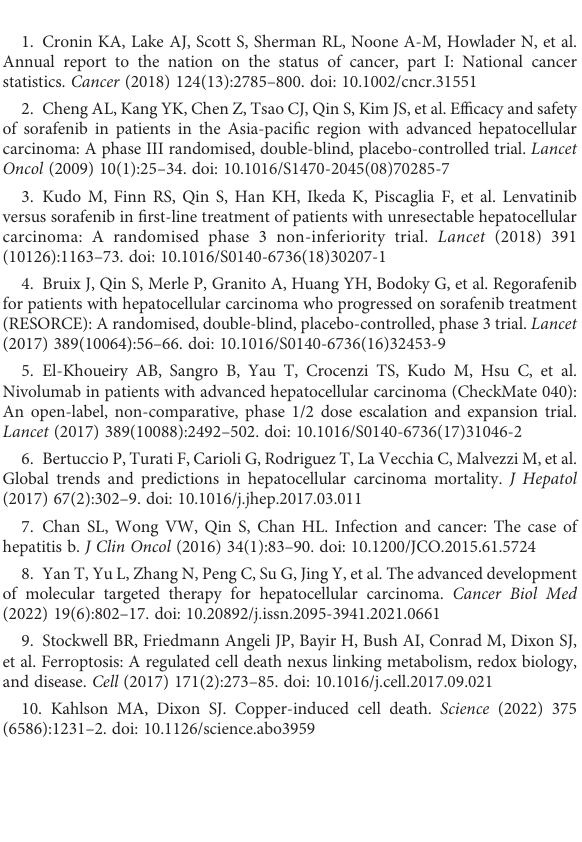
SUPPLEMENTARY FIGURE 2 The correlation between the expression level of promising immune checkpoints. (A) The correlation between risk scores and PCDD1. (B) The correlation between risk scores and CD274 (PD-L1). (C) The correlation between risk scores and